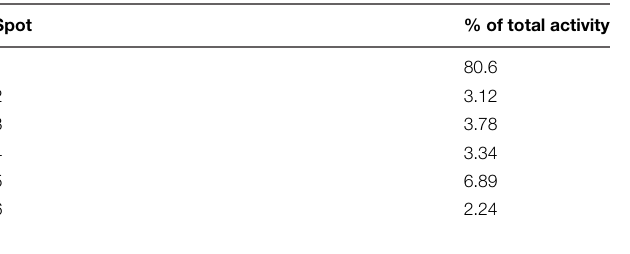
TABLE 1 | Densitometric evaluation of peroxidase activity in 2D gel analysis.